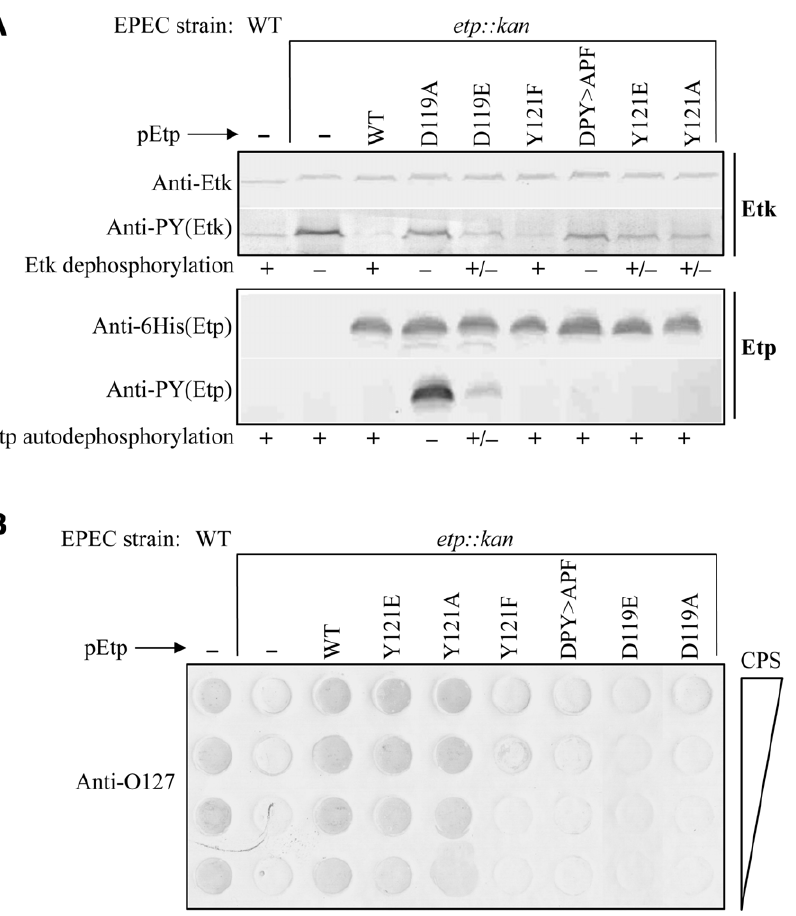
Figure 5. EtpY121F retained phosphatase activity but failed to support capsule formation. (A) Proteins were extracted from wild-type EPEC, the D etp::kan mutant, or mutant complemented with plasmids derived from pEtp (pCNY506) and expressing different Etp variants with C- terminal 6His tags. The levels of Etk, phosphorylated Etk, recombinant Etp, and phosphorylated Etp were determined by Western blot analysis using anti-Etk, anti-6His, and anti-PY antibodies. The strain and the complementing mutant of Etp are indicated above the blots and the antibodies used in the immunoblots are indicated on the left side. The levels of Etk dephosphorylation and Etp autodephosphorylation are indicated below the blots. (B) Capsule polysaccharide was extracted and purified from the same strains presented in (A). Two-fold serial dilutions of purified capsule were dotted on PVDF and developed with anti-O127 antibody. The identity of the strain and complementing plasmid are indicated above the blot and direction of capsule polysaccharide dilution is indicated at the right side of the blot.